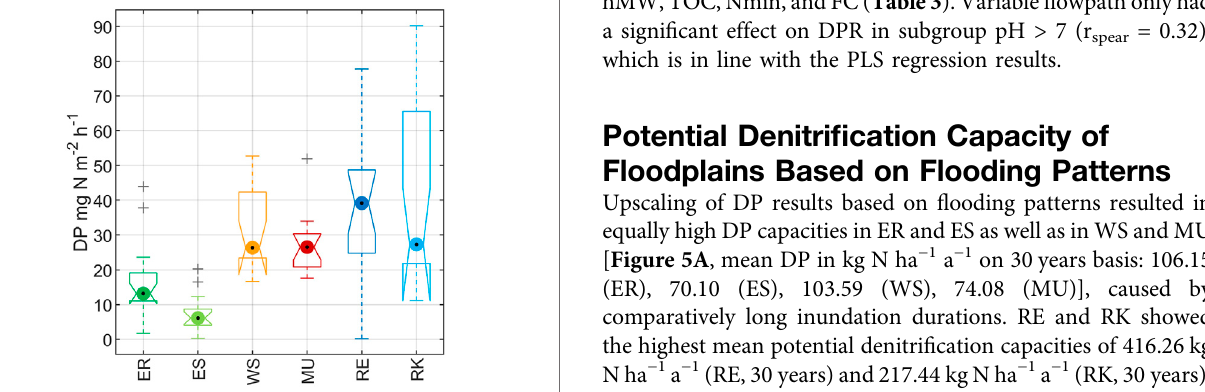
[ Figure 5A , mean DP in kg N ha − 1 a − 1 on 30 years basis: 106.15